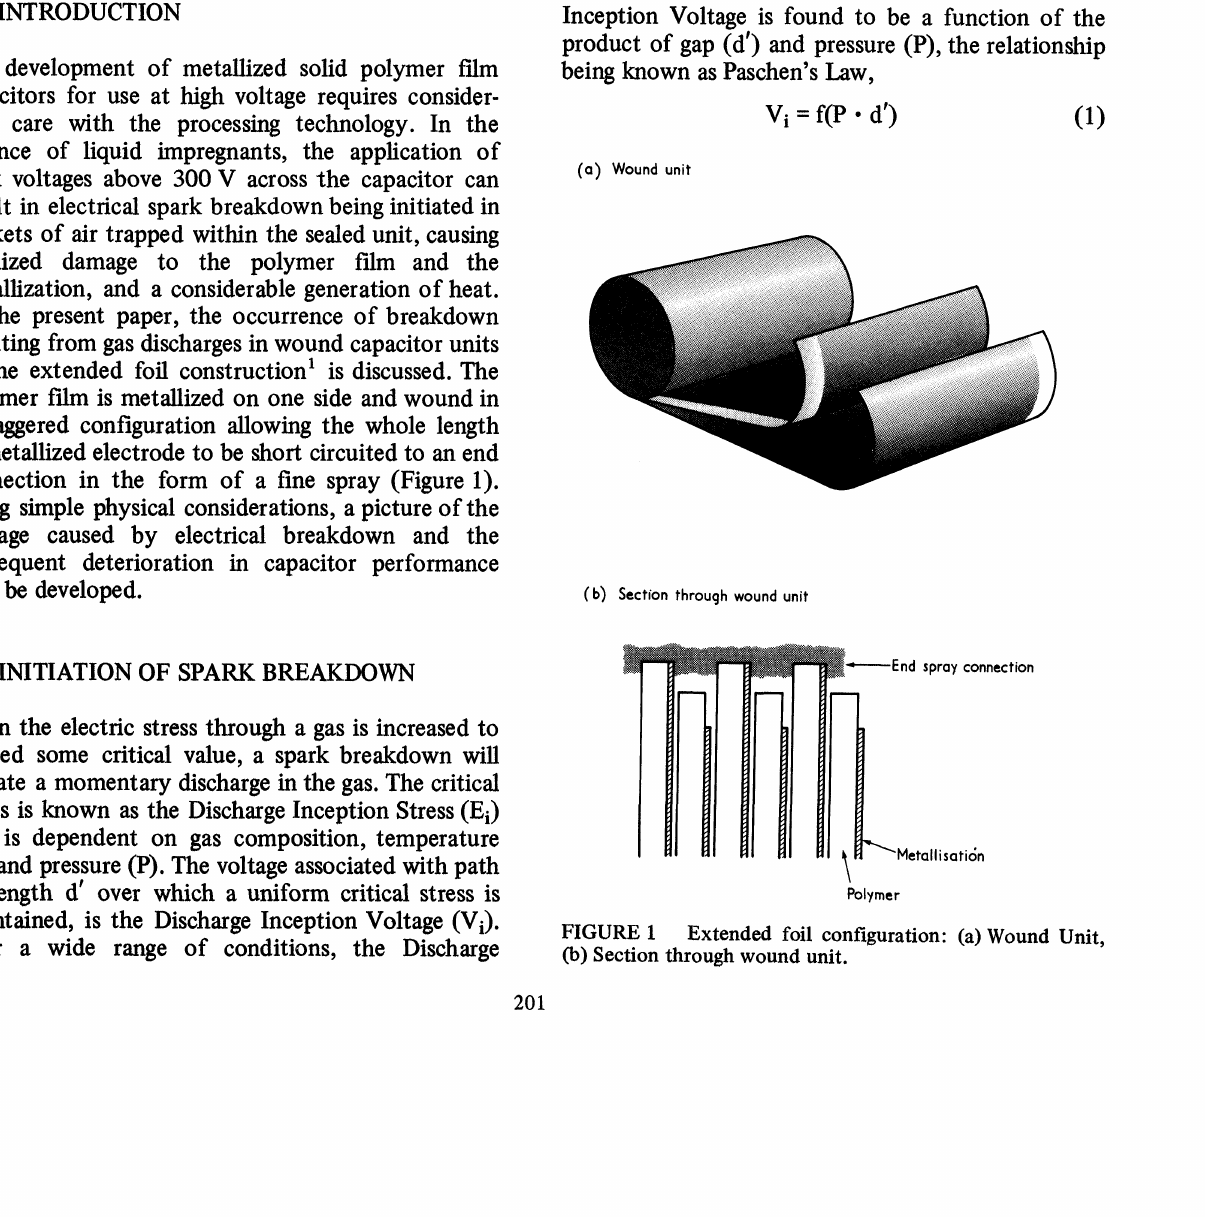
Extended foil configuration: (a)Wound Unit, (b) Section through wound